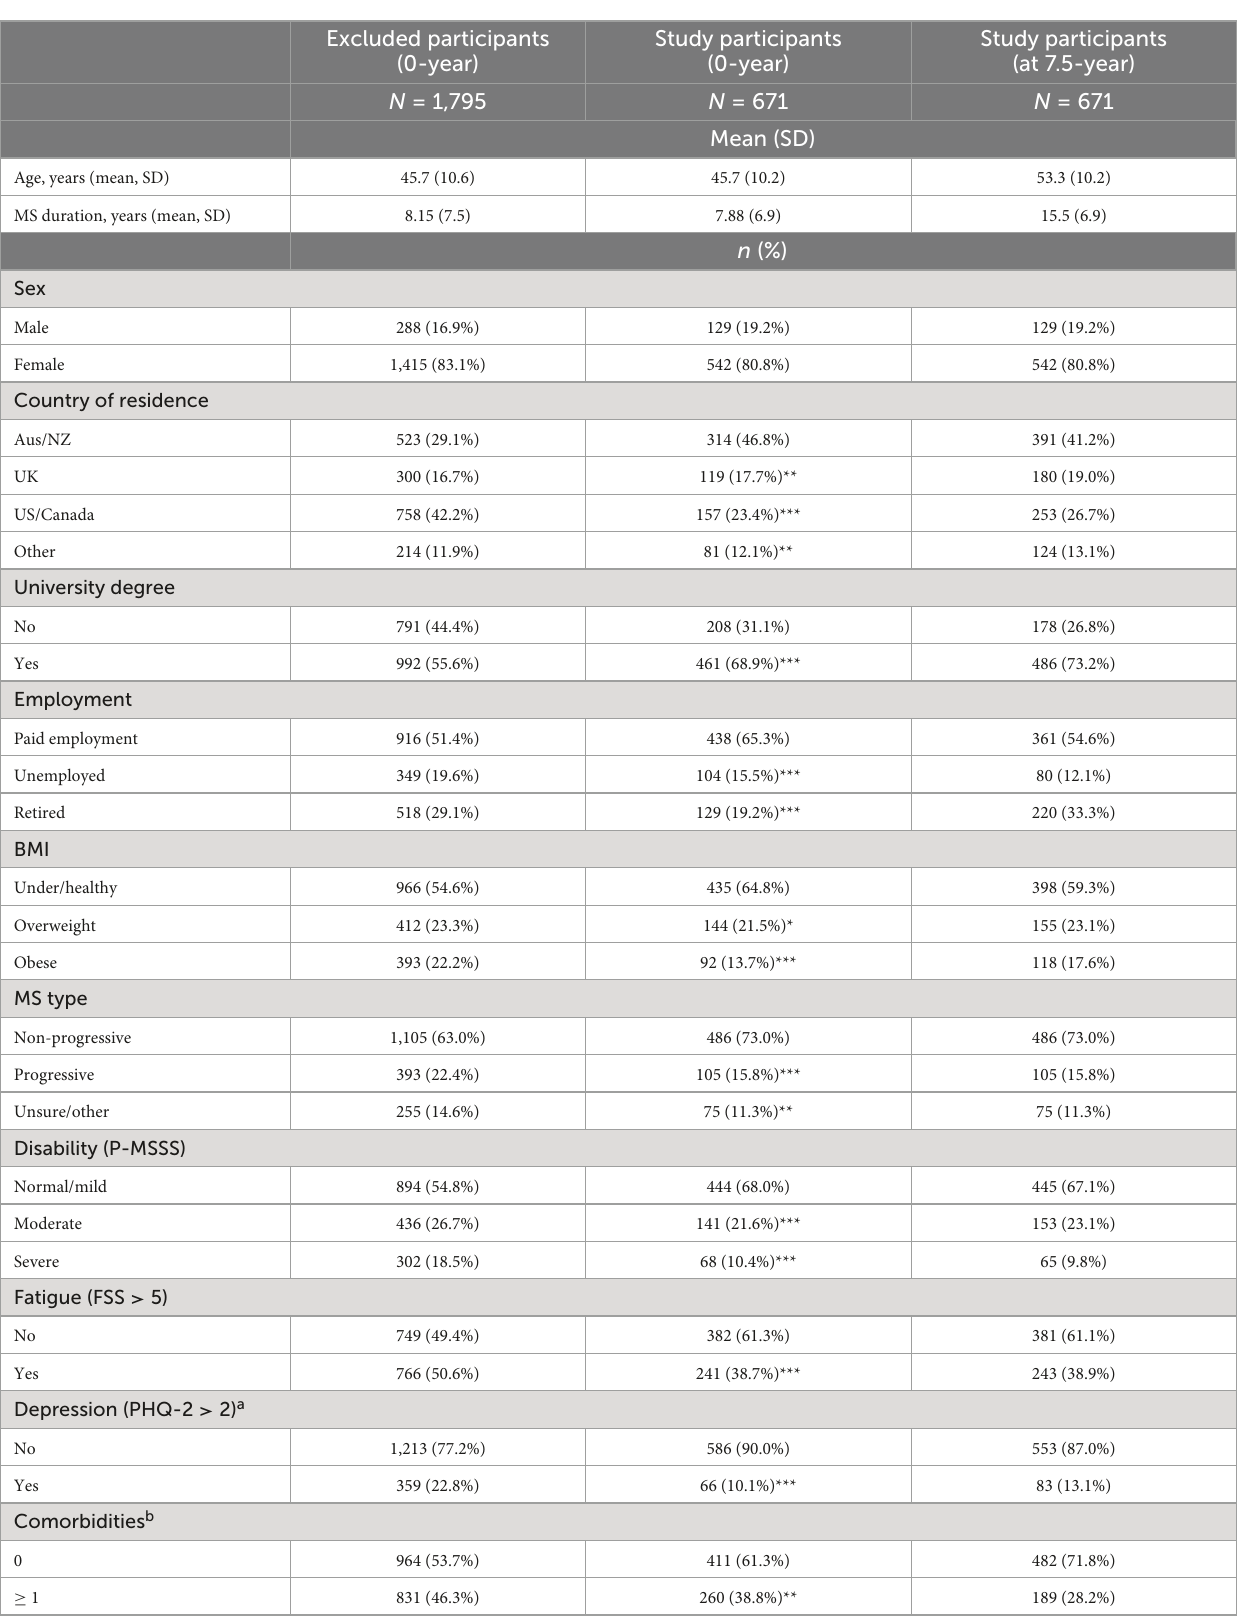
TABLE 1 Participant sociodemographic and clinical